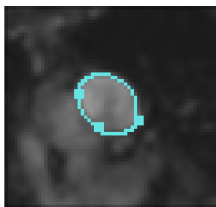
Figure 5. We use Gout et al. [19] algorithm. The initial guess is given outside the region of interest, it ( X − 30 ) 2 ( Y − 30.5 ) 2 + − 1, the time step is equal to 0.3, space step is equal to is defined by Ψ = 15 2 23 2 0.1, distance is computed using the fast marching method (Sethian [14]) and the regularization term is equal to 0.8. Top left : Interpolation condition and initial guess. Top right : iteration 80. Bottom left : Iteration 100. Bottom right : Iteration 160.